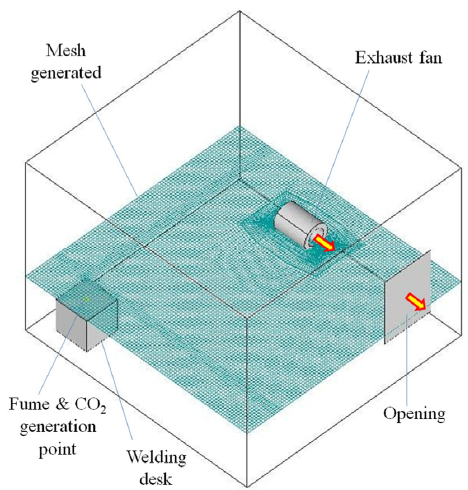
Figure 4. Model and mesh generation in Airpak.